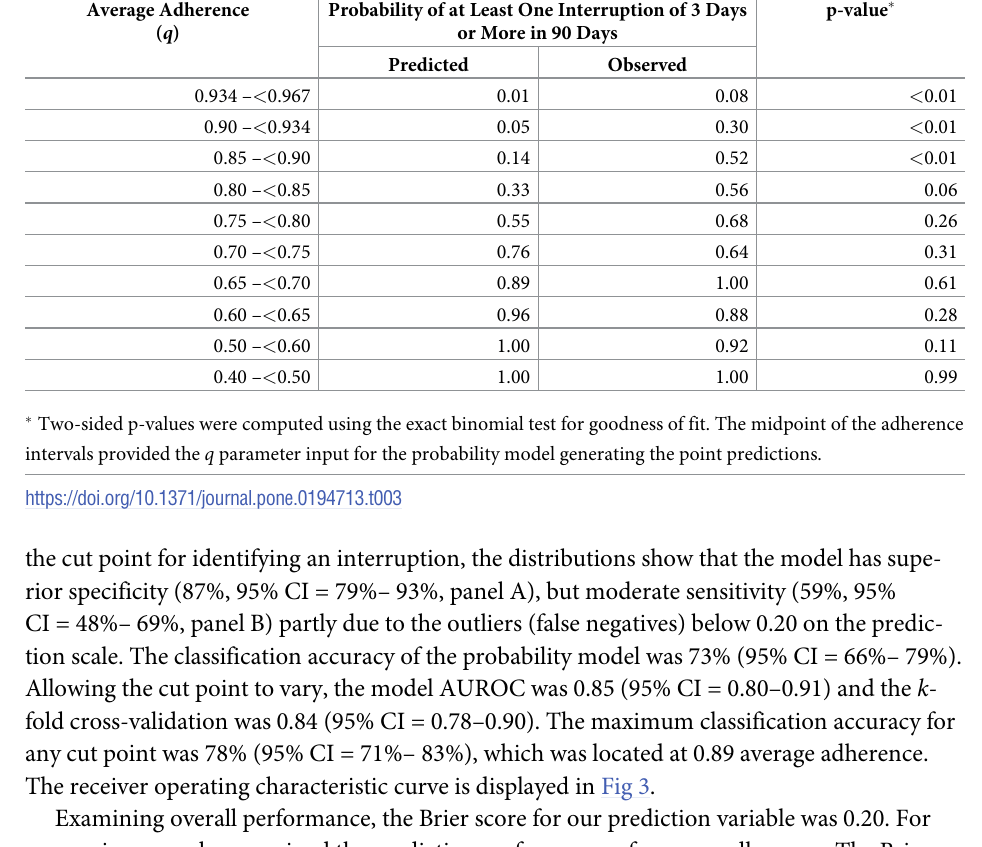
Table 3. Comparison of the predicted and observed proportion of participants with at least one (cid:21) 3 day ART interruption in the course of 90 days ( r = 3, n = 90) by average adherence. Average Adherence ( q )